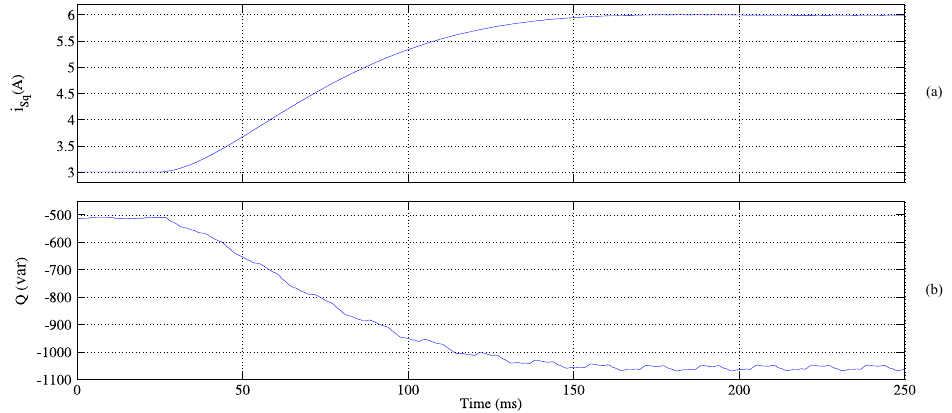
Figure 8. Step responses for a change from 3 A to 6 A in i ∗ DHPF-NSI; ( b ) reactive power generated by the